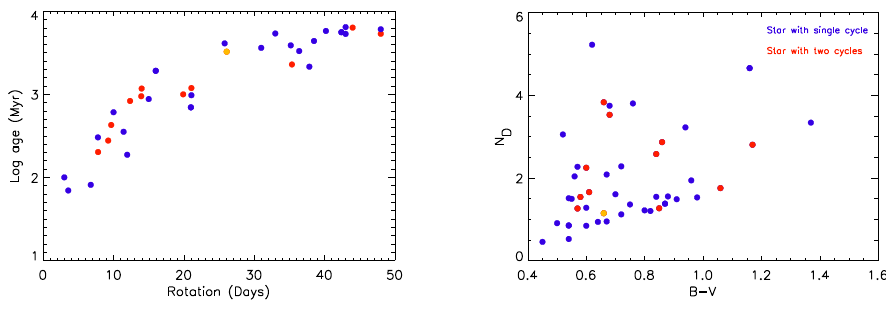
Fig. 1. Left panel: Star age as function of rotation rate. Right panel: Dynamo number as function of B-V.